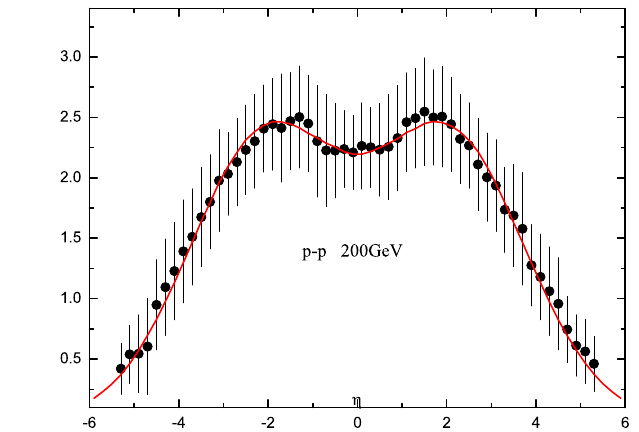
Figure 1. (Color online) Pseudorapidity distribution of charged particles produced in pp collisions √ s NN = 200 GeV. Filled circles represent experimental data measured by the PHOBOS Collabora- at tion [14]. The theoretical result is presented by a